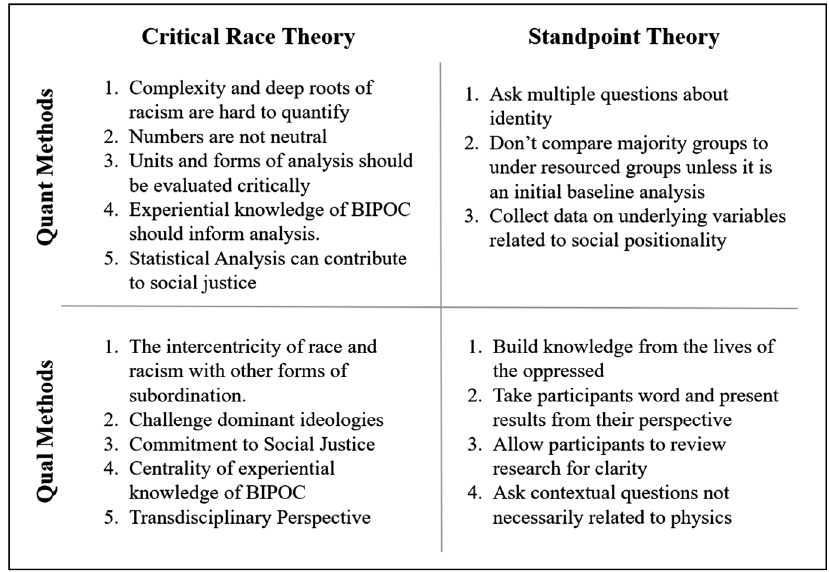
FIG. 3. Summary of how to apply CRT and SPT in qualitative and quantitative